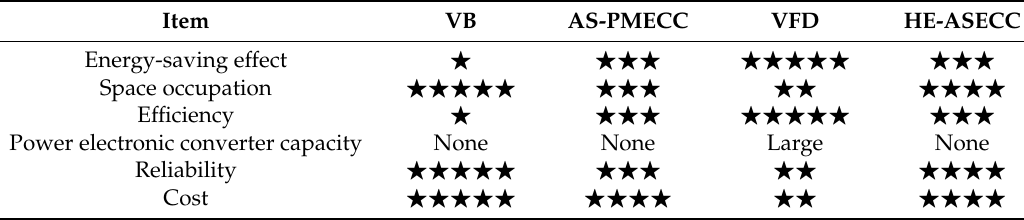
Table A1. Full comparison among different energy saving